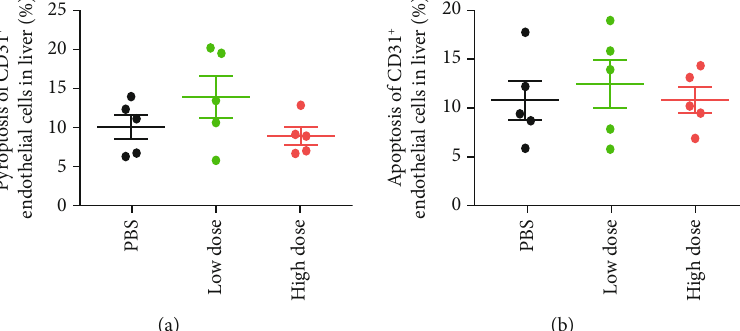
Figure 5: E ff ect of the administration of various doses of HNP-1 on liver endothelial cell death during sepsis progression. Wild-type mice were intraperitoneally administered a high dose of HNP-1 (10 mg/kg body weight), a low dose of HNP-1 (0.5 mg/kg body weight), or PBS 6 hours after CLP. (a) Quanti fi cation of pyroptotic endothelial cells in the liver at 48 hours after CLP using fl ow cytometry. The results shown are the means ± SEMs of 5 mice in each group. (b) Quanti fi cation of apoptotic endothelial cells in the liver at 48 hours after CLP using fl ow cytometry. The results shown are the means ± SEMs of 5 mice in each group.